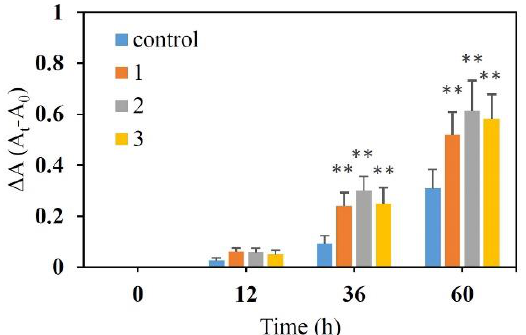
Figure 6. Growth stimulation of fructan 1 , 2 and 3 on Bifidobacterium longum . ** p < 0.01 compared to the control.